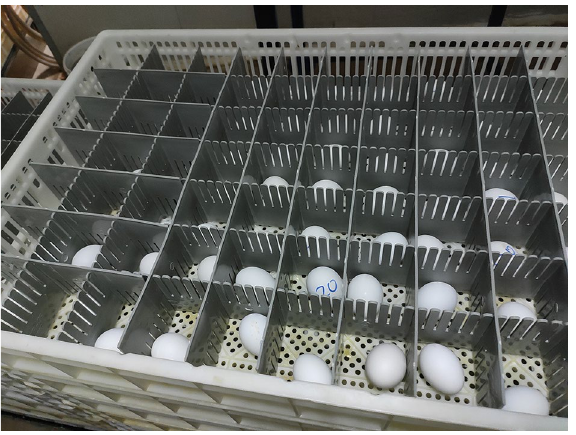
Figure 2. Divided incubation tray structure.